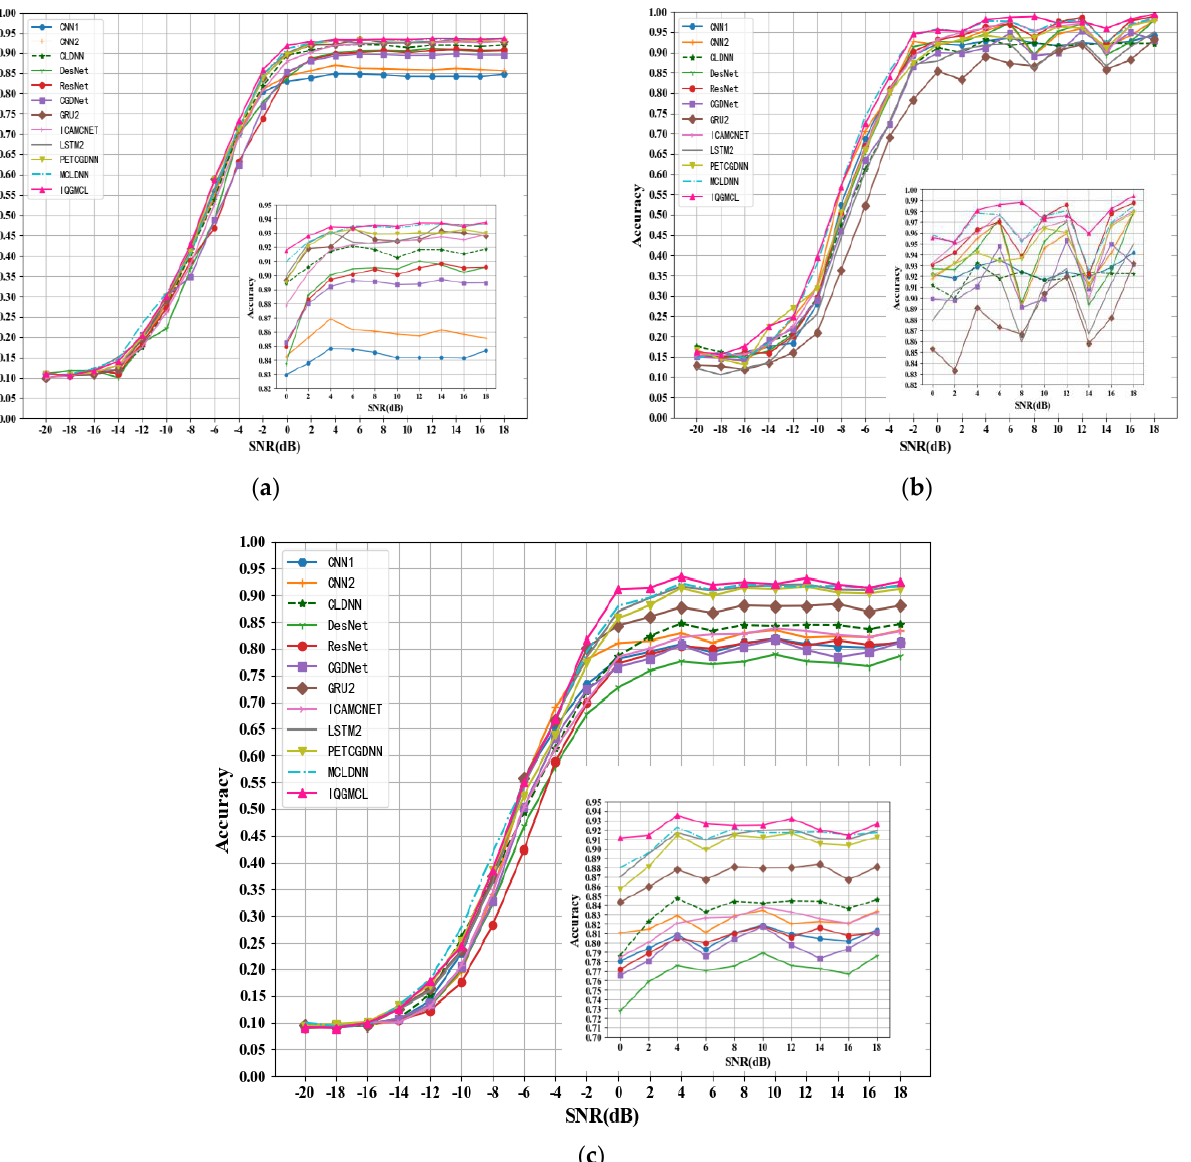
Figure 7. Comparison results on three datasets. ( a ) Comparison results of RML2016.10b dataset; ( b ) comparison results of RML2016.04c dataset; ( c ) comparison results of RML2016.10a dataset.